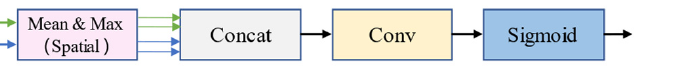
Figure 7. Unified Attention Fusion Module.